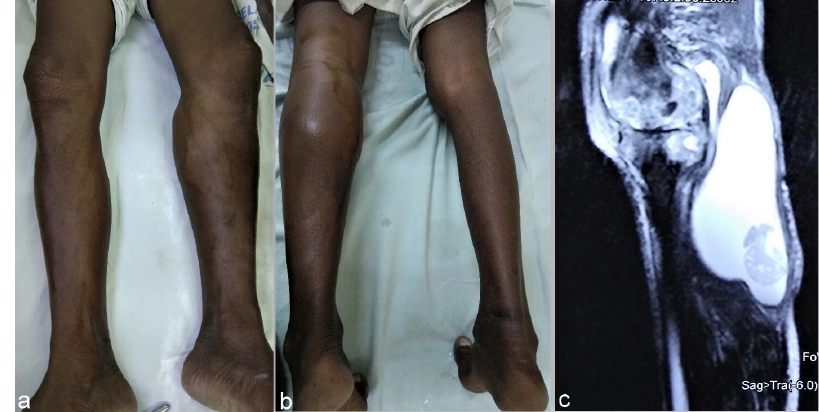
Figure 1. The clinical image of left calf swelling as compared to opposite side (a). The swelling is better appreciated in prone position (b). The T2-weighted MRI images in sagittal (c) view showing significant fluid collection in the calf region that is in communication with the native knee joint following rupture of popliteal